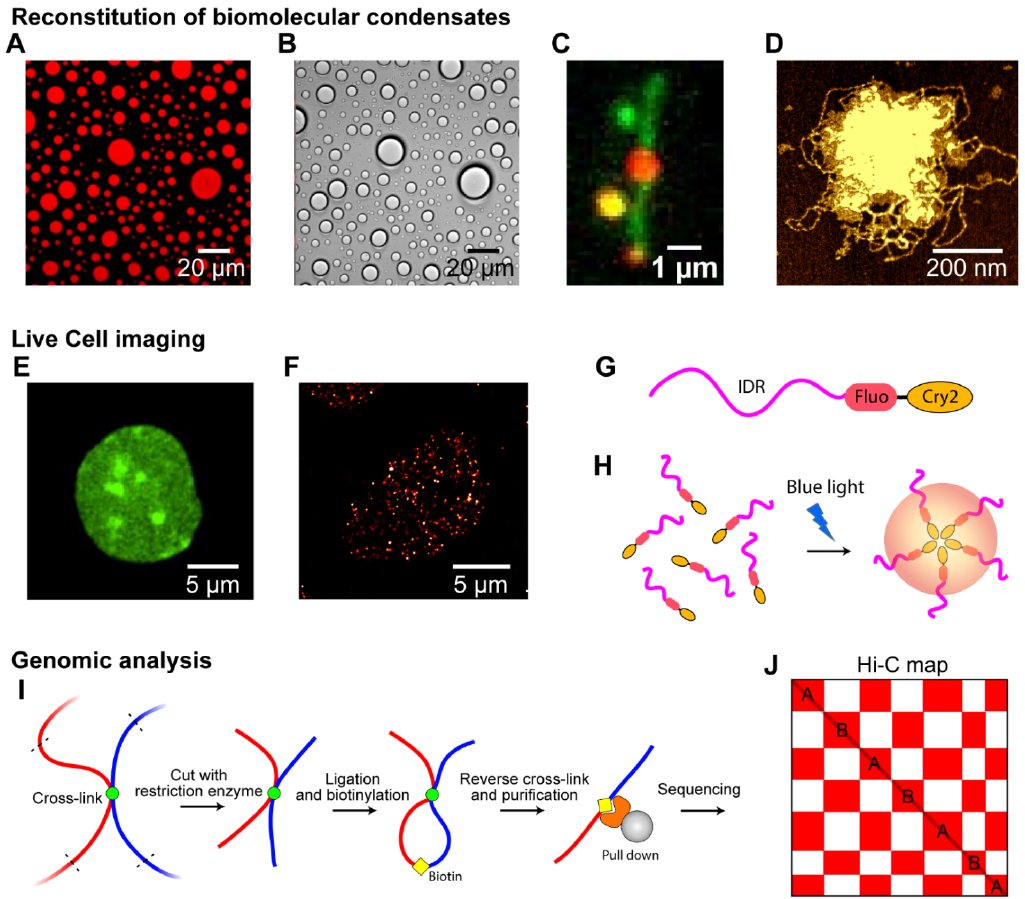
Figure 3. Techniques to observe phase separation in chromosomes. ( A – D ) Reconstitution of biomolecular condensates in vitro. ( A ) Fluorescence microscopy image showing liquid droplets of fluorescently labeled PRM-SH3-6His in the presence of Ni 2+ ions obtained with a wide-field microscope (mCherry was fused with the protein) [38]. ( B ) DIC microscopy image showing unlabeled droplets of PRM-SH3-6His. ( C ) Single-molecule DNA tethered assay with fluorescent-stained DNA (green) and labeled cohesin proteins (red) forming condensates with DNA [20]. ( D ) AFM image of an unlabeled cohesin/DNA condensate [20]. ( E – H ) Live-cell imaging of biomolecular condensates. ( E ) Confocal microscopy image showing HP1 α in the nucleus of a HCT116 cell. The condensates of Dendra2-tagged HP1 α are clearly visible. ( F ) Super- resolution images of the Dendra2-Pol II cluster in a HCT116 cell obtained using a PALM microscope [19]. ( G ) Construct for “optoDroplet,” combining optogenetic-induced oligomerization with IDR-driven phase separation. The IDR (magenta) driving phase separation is fused with a fluorescent protein (red) and Cry2, a protein domain that forms oligomers upon blue-light activation [116]. ( H ) Blue-light activation induced the oligomerization of Cry2, which controls the interactions between IDRs to induce phase separation. ( I , J ) Genomic analysis via Hi-C. ( I ) Experimental scheme for Hi-C experiments. ( J ) Example genome-wide contact map (Hi-C map of compartmentalization). The X and Y axes denote the genomic positions in a chromosome. A and B compartments are shown in the Hi-C map by the “checkerboard” pattern. High frequencies of contacts are colored red, and low frequencies,